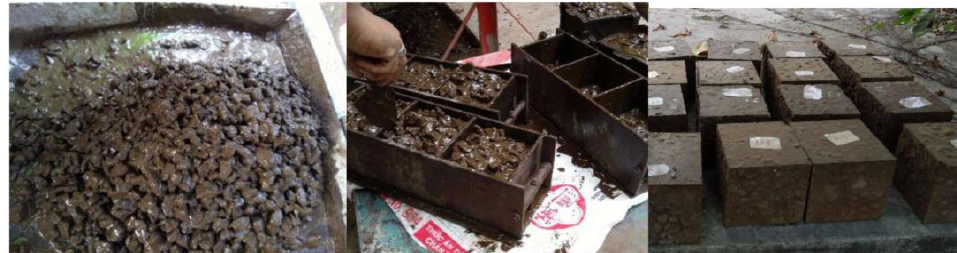
Figure 5. Manufacturing procedure of geopolymer recycled aggregate concrete (GRAC) speci-